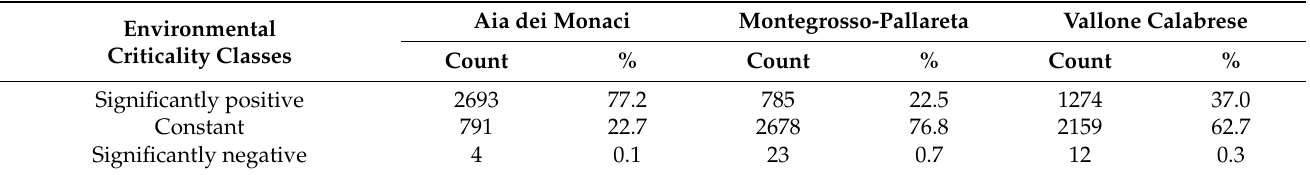
Table 5. Percentage distribution of the environmental criticality classes for the survey sites.